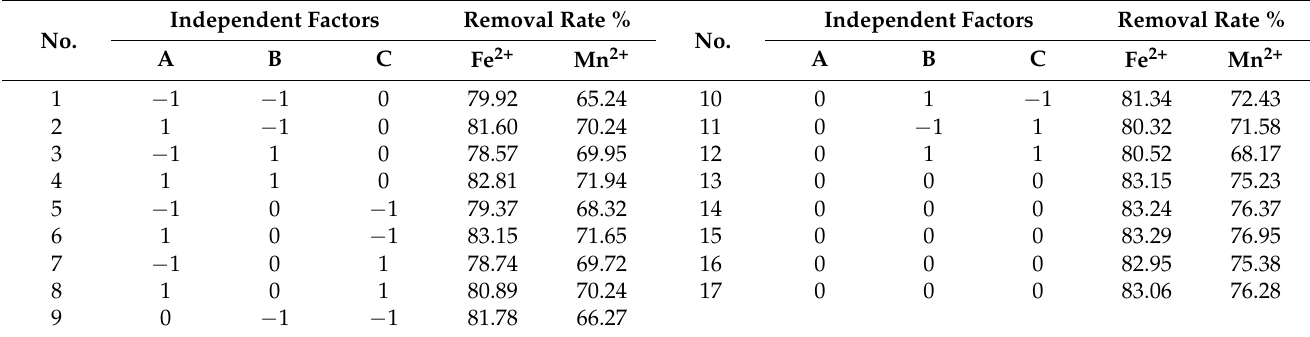
Table 3. Experimental design and results.